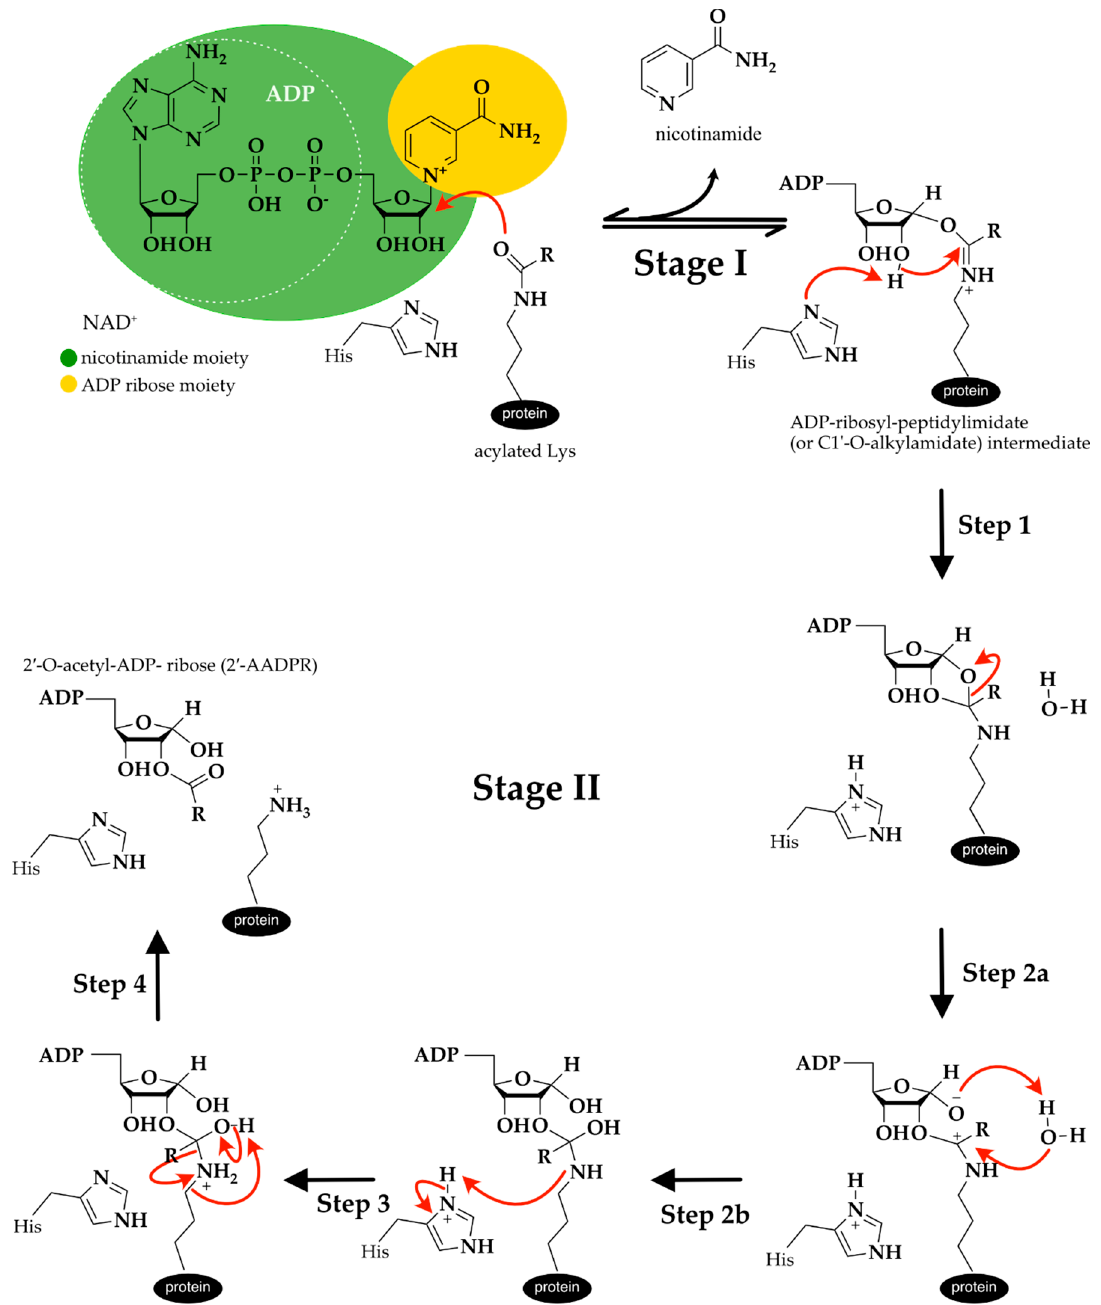
Figure 4. Sirtuins’ catalytic mechanism proposal [122] . The red arrows represent the movement of electrons.